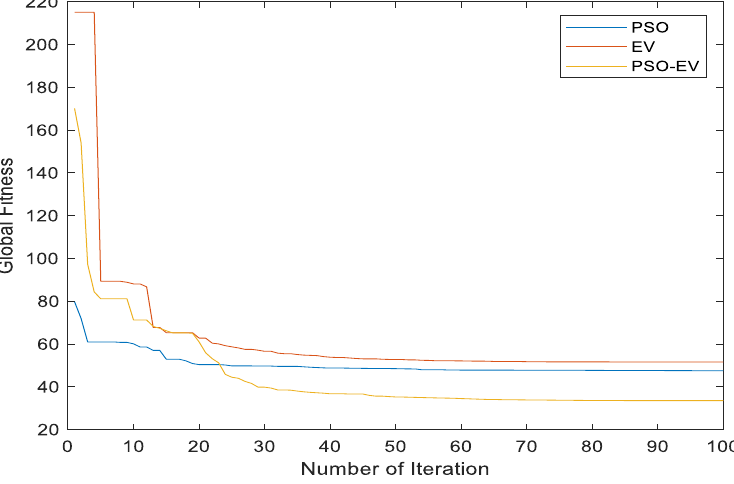
Figure 2. Global fitness comparison: PSO vs. EV vs. PSO-EV for Pima dataset.